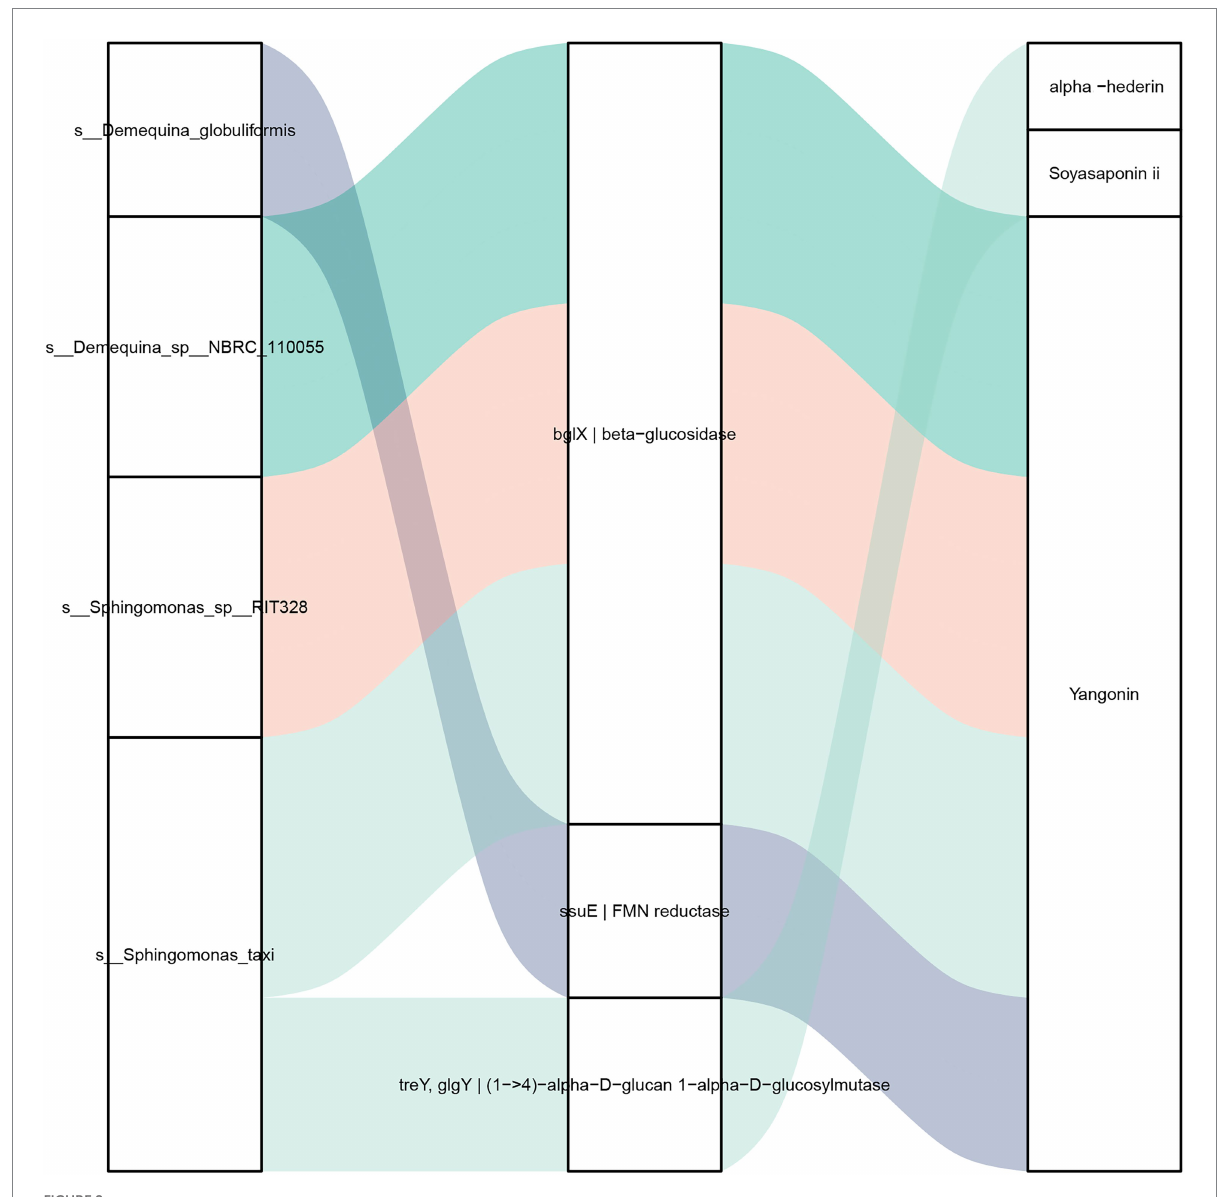
FIGURE 8 Correlation analysis of intestinal bacteria species, functional genes and metabolites of L. vannamei . Left: bacteria species, middle: functional genes, right: metabolites. The line between the bacteria species and functional gene indicates the contributing bacteria of the functional gene. The line between the functional genes and metabolites represents they have significant correlation (| r | > 0.8, p <